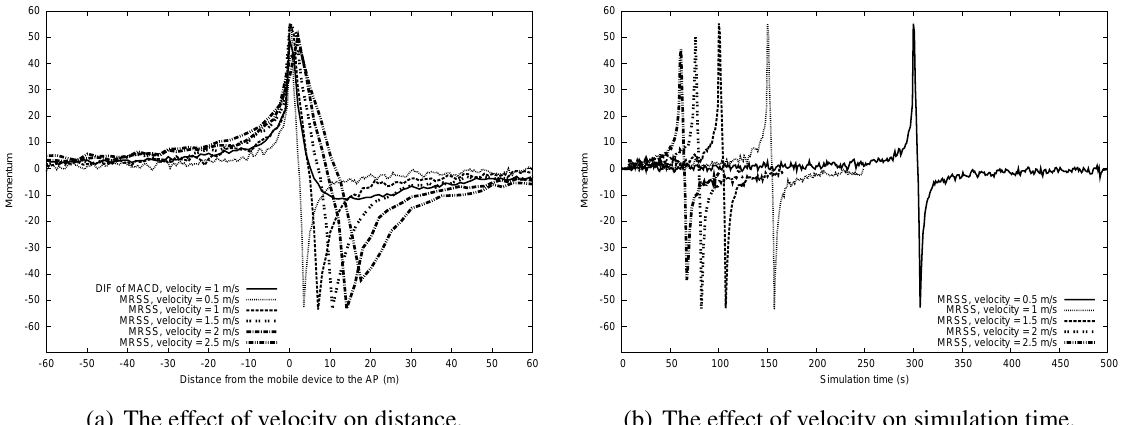
Figure 7. The effect of velocity in the WLAN